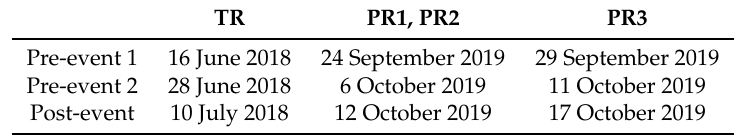
Table 1. Acquisition dates of the imagery used in this study.